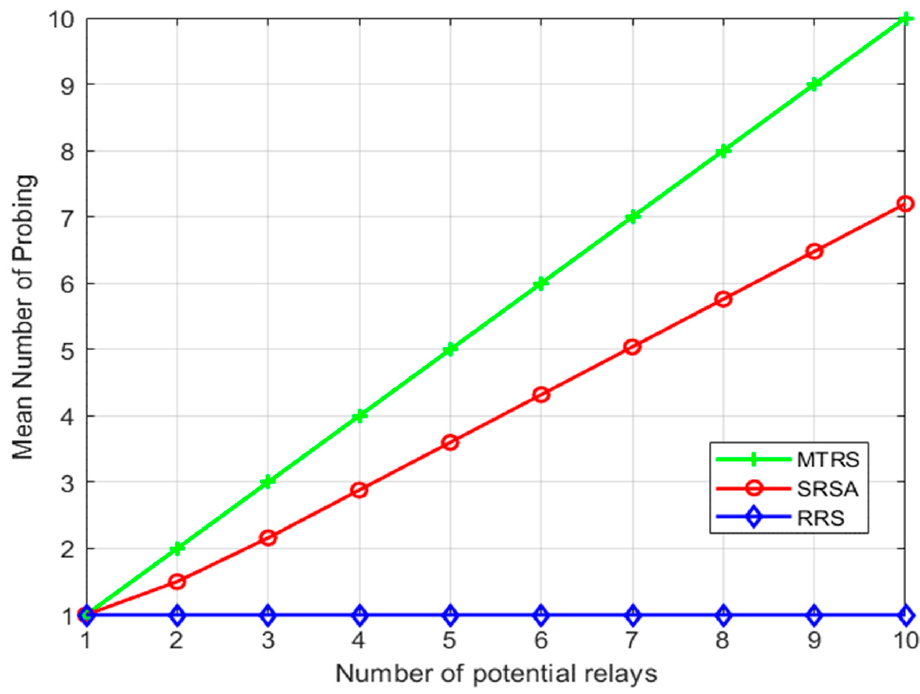
Figure 2. Average detection times of each algorithm.